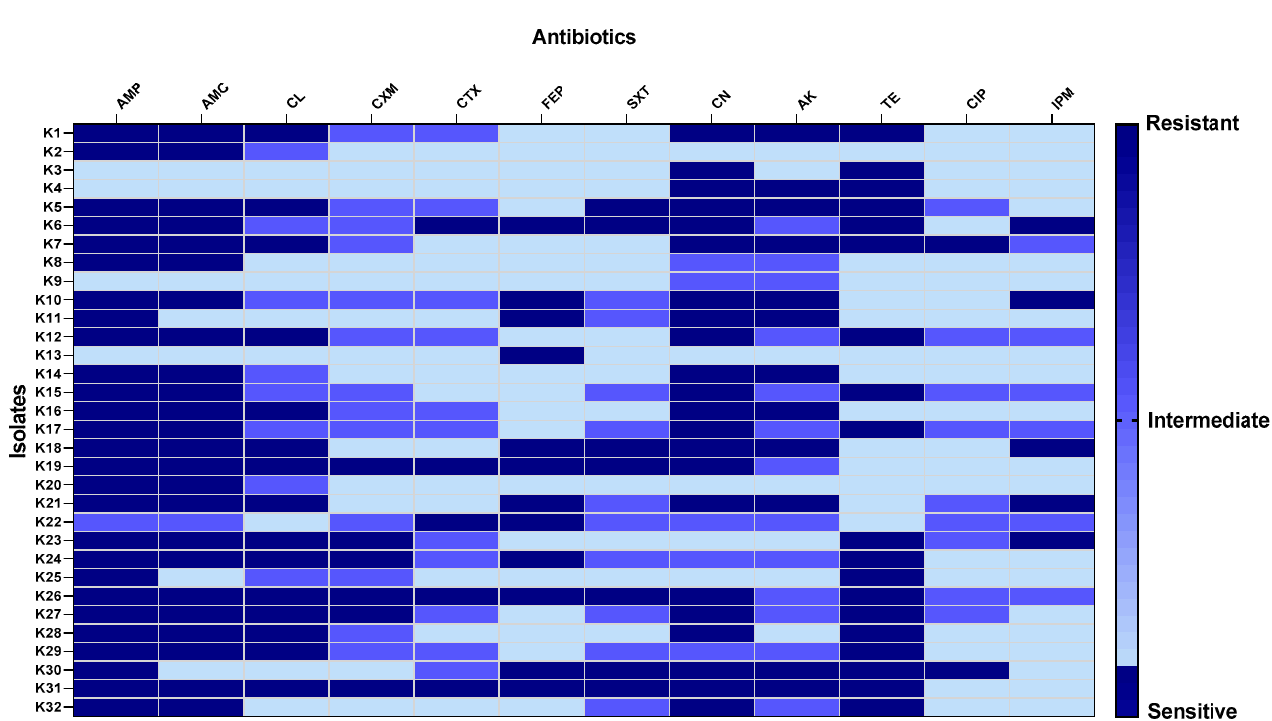
Figure 10. Heat map showing antibiotic susceptibility of K. pneumoniae isolates. AMP: ampicillin, AMC: